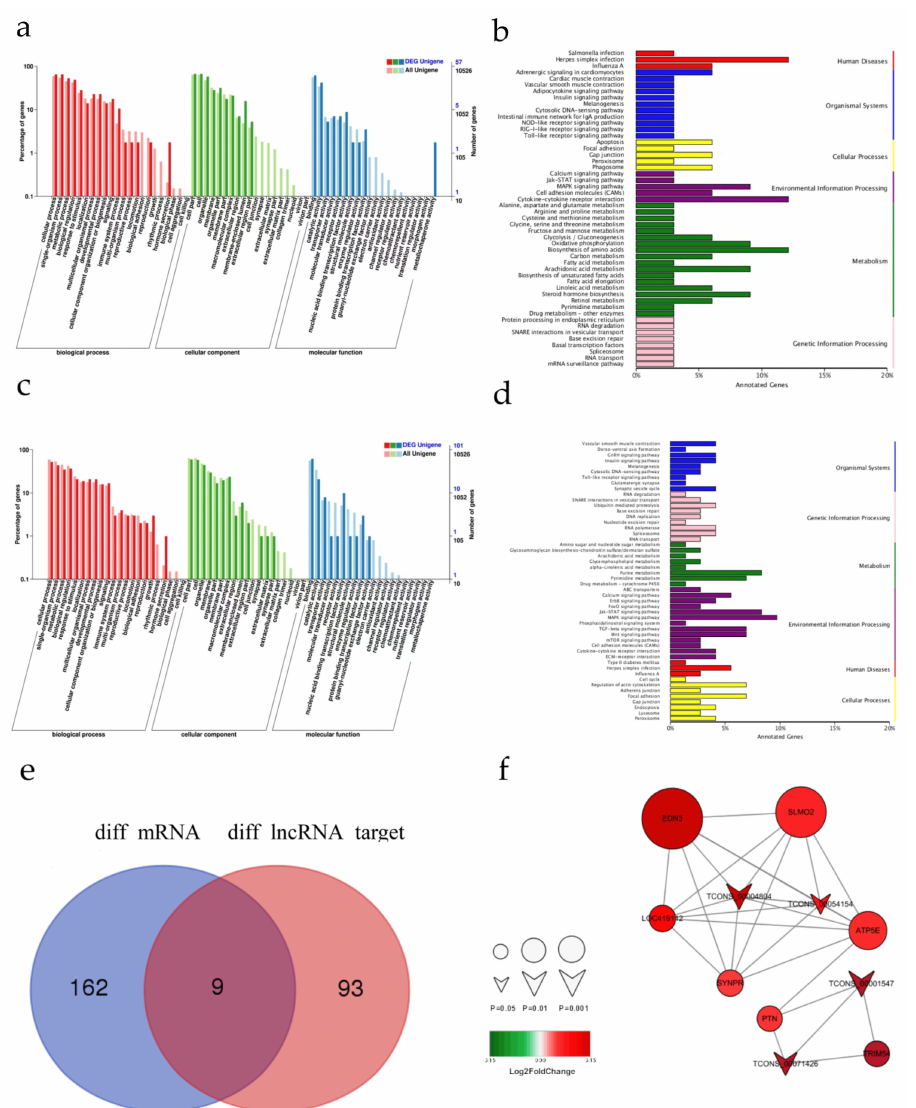
Figure 4. Functional enrichment of BS and YS tissue-derived lncRNA targets and comprehensive analysis of lncRNA-mRNA co-expression. ( a ) Comparison of the GO functional annotations of the cis target genes. ( b ) KEGG pathway annotations of cis target genes. ( c ) Comparison of the GO functional annotations of the trans target genes. ( d ) KEGG pathway annotations of the trans target genes. ( e ) Venn diagram of differentially expressed lncRNA target genes and differential mRNAs. ( f ) Differentially expressed lncRNA-mRNA network. Red and green indicate up- and downregulated genes, respectively. The shape size indicates logP; the smaller the p value is, then the larger the shape